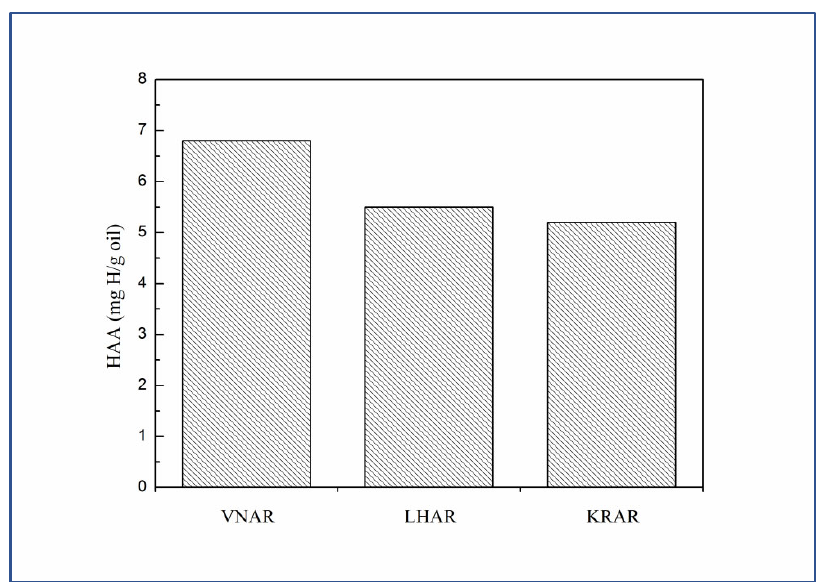
Figure 2. HAA of the three residues.